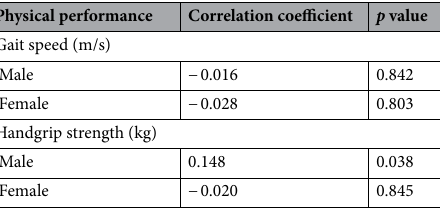
Table 2. Correlation of circulating FSTL-1 level with physical performance. Gait speed and hand grip were examined in 294 (78.2%) patients. FSTL-1 follistatin-like protein-1.